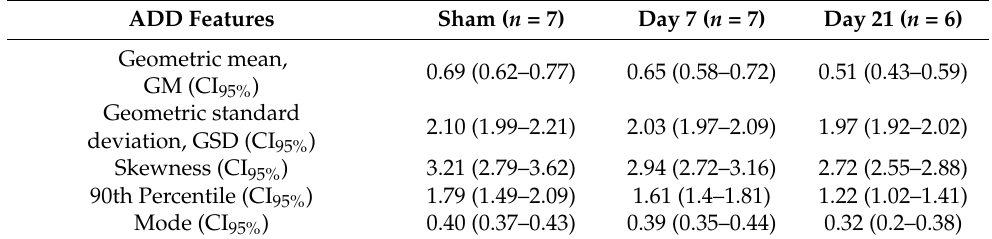
Table 1. Changes in relative ADD features following